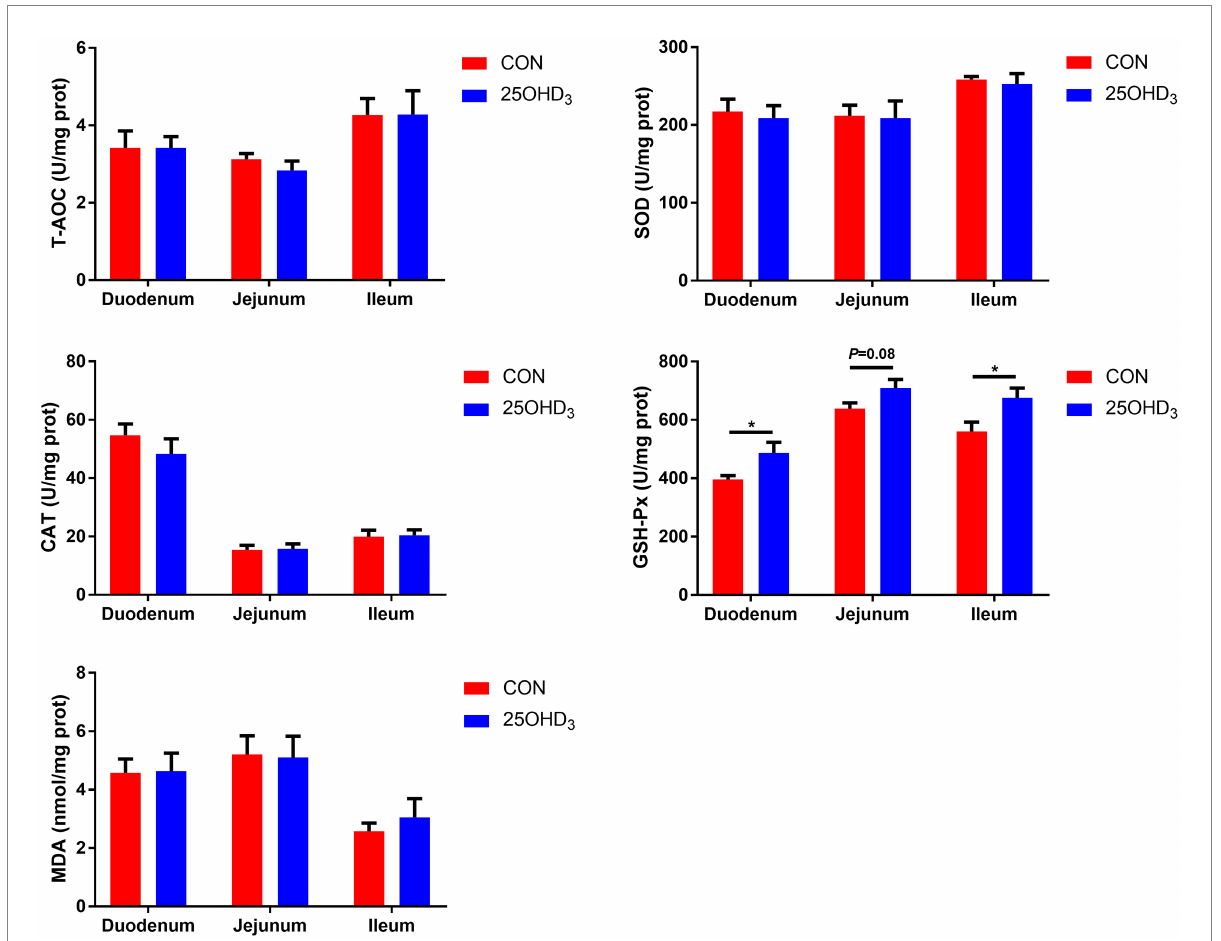
FIGURE 3 The mucosal antioxidant parameters between the two treatments. Values are shown as the means ± SEM, n = 5. * p < 0.05 versus CON group. T-AOC, total antioxidant capacity; SOD, superoxide dismutase; CAT, catalase; GSH-Px, glutathione peroxidase; MDA,